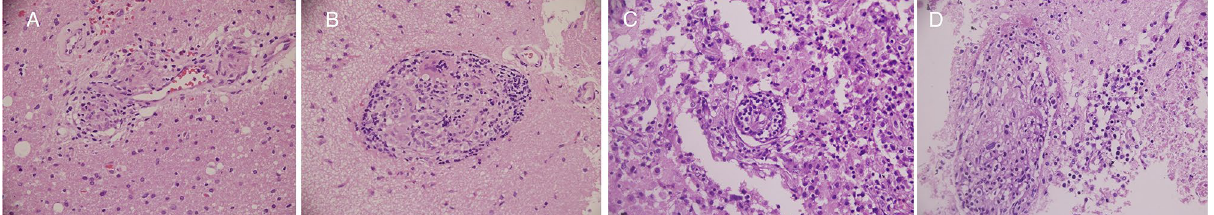
Figure 2. Photomicrographs showing non-necrotizing granulomas involving the vessel wall on Hematoxylin and Eosin stain at 200 × ( A ) and 400 × ( B ) respectively. Photomicrographs showing lymphocytic vasculitis ( C ) and thrombus formation in the vessels ( D